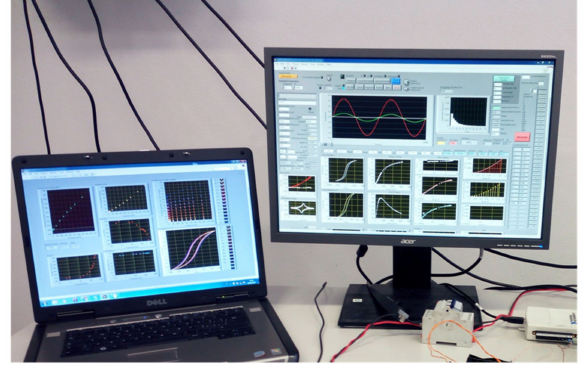
Figure 4. Interface of magnetic characterization